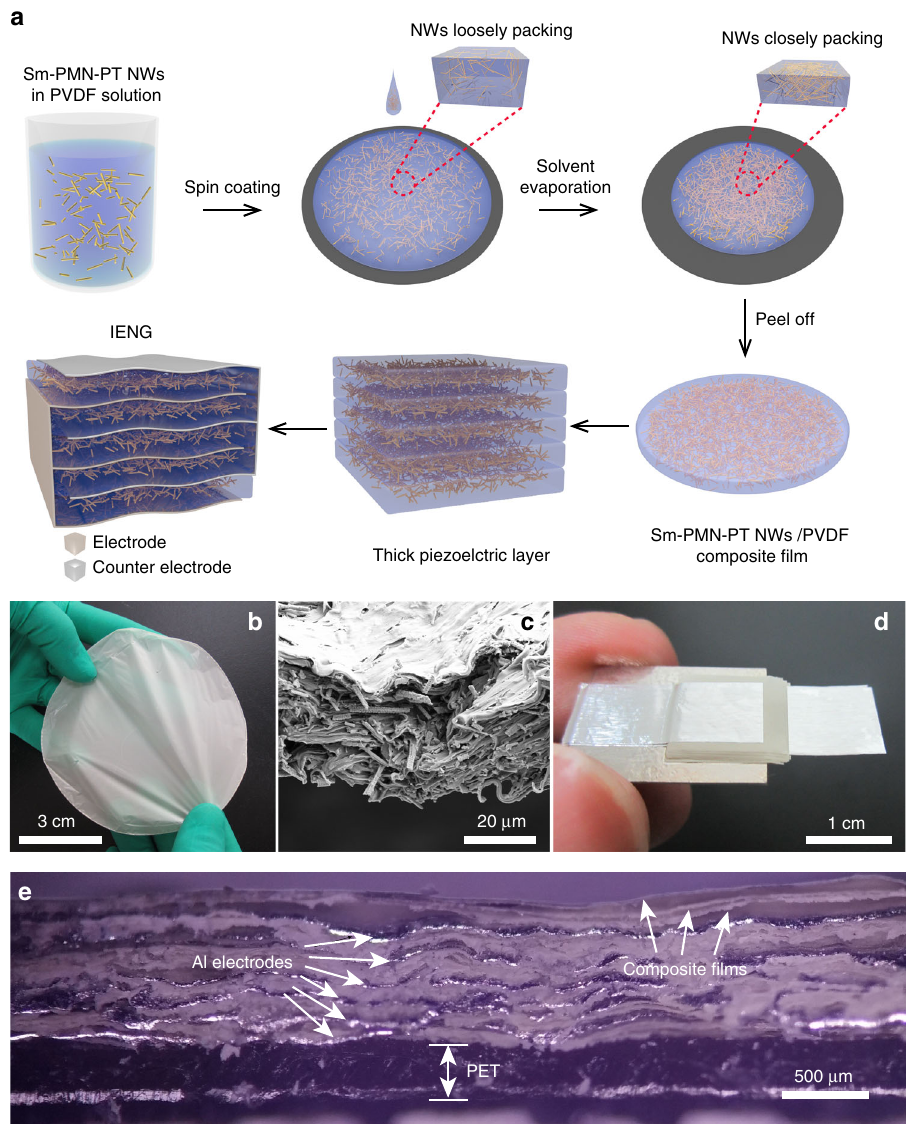
Fig. 3 Fabrication and characterization of the IENG. a Schematic diagram of the fabrication process for IENG. b Optical image of a round Sm-PMN-PT/ PVDF composite fi lm with diameter of 9 cm. c Cross-section image of the composite fi lm in b . d Optical image of a fabricated IENG with 7 units. Al electrodes on each side is connected as one electrode forming a three-dimensional intercalation electrode. e The corresponding cross-section image of IENG. Al electrodes, composite fi lms and PET are marked by white